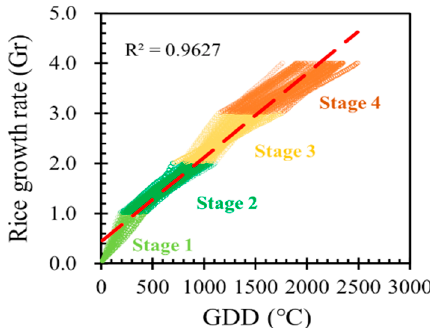
Table 1. GDD in each specific key stage.